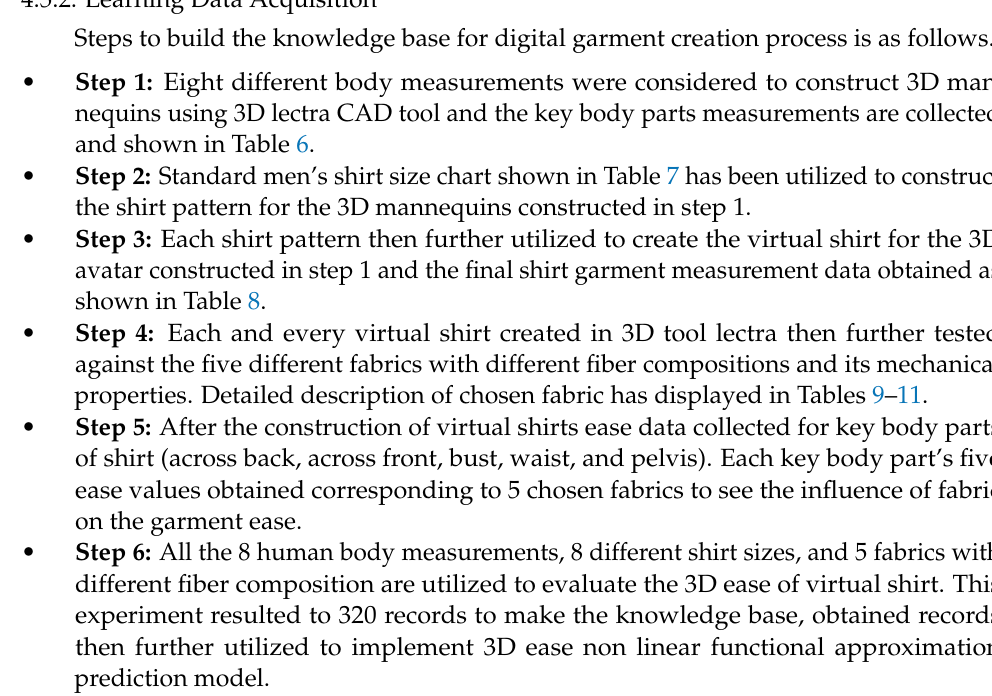
Table 6. 3D Mannequins key body part’s measurement data for virtual shirt. 3D Mannequin’s Key Body Measurement for